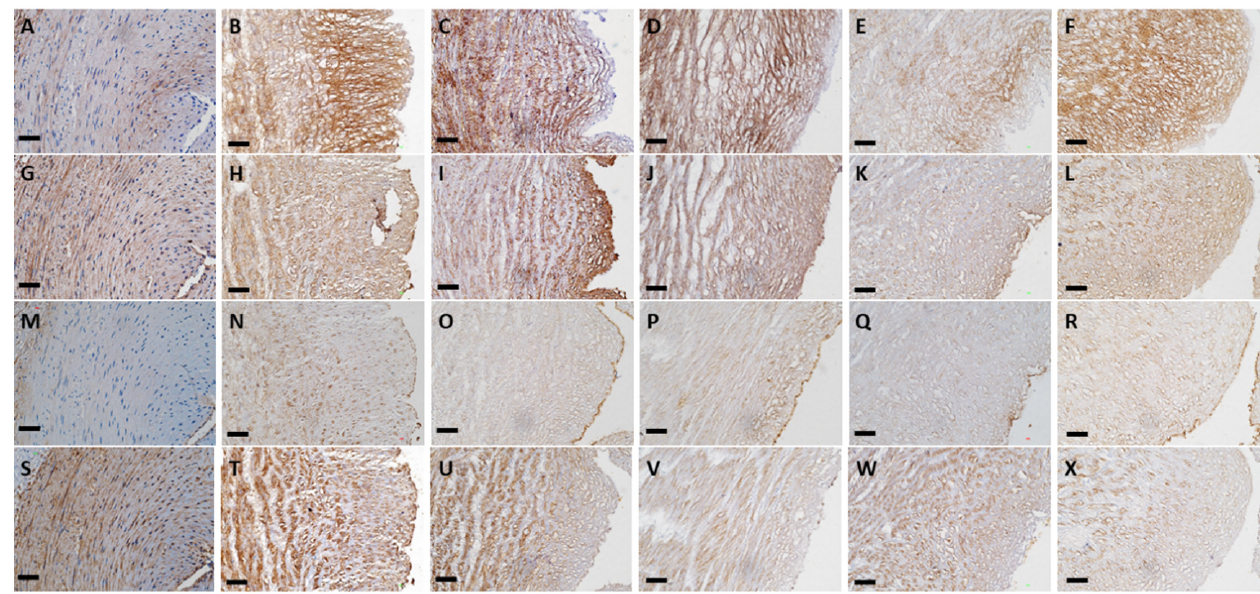
Figure 2. IHC stain of HUA, cDHUA, and sDHUA. ( A , G , M , S ) HUA; ( B , H , N , T ) cDHUA; ( C , I , O , U ) sDHUA, 204 W for 4 h; ( D , J , P , V ) sDHUA, 204 W for 8 h; ( E , K , Q , W ) sDHUA, 285 W for 2 h; ( F , L , R , X ) sDHUA, 285 W for 4 h; ( A – F ) Collagen type I; ( G – L ) Collagen type III; ( M – R ) Fibronectin; ( S – X ) Laminin; Magnification: 200 × , Scale bar = 50 µ m.